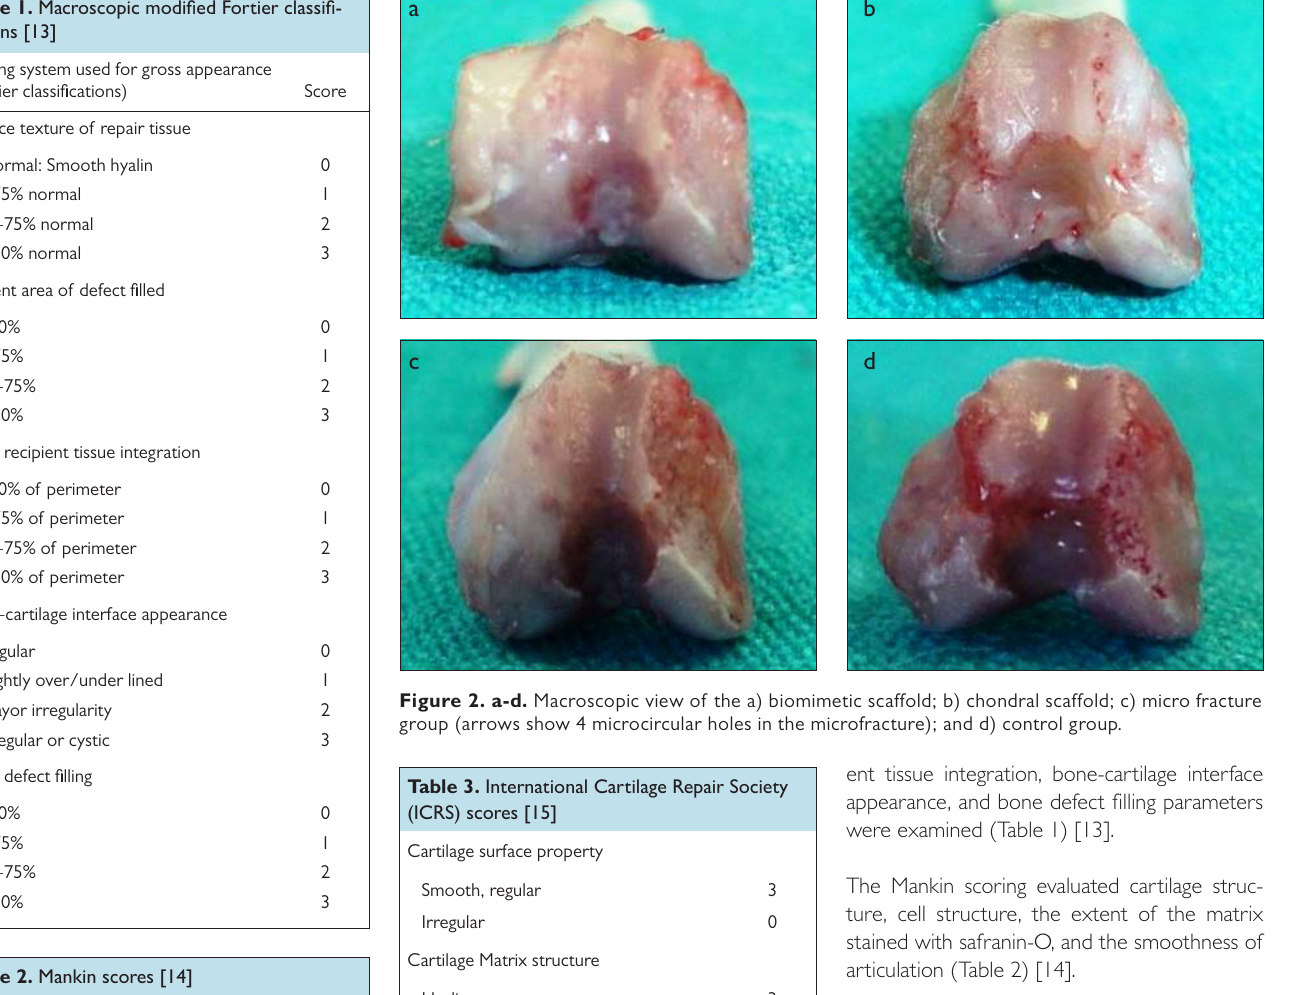
Table 2. Mankin scores [14]